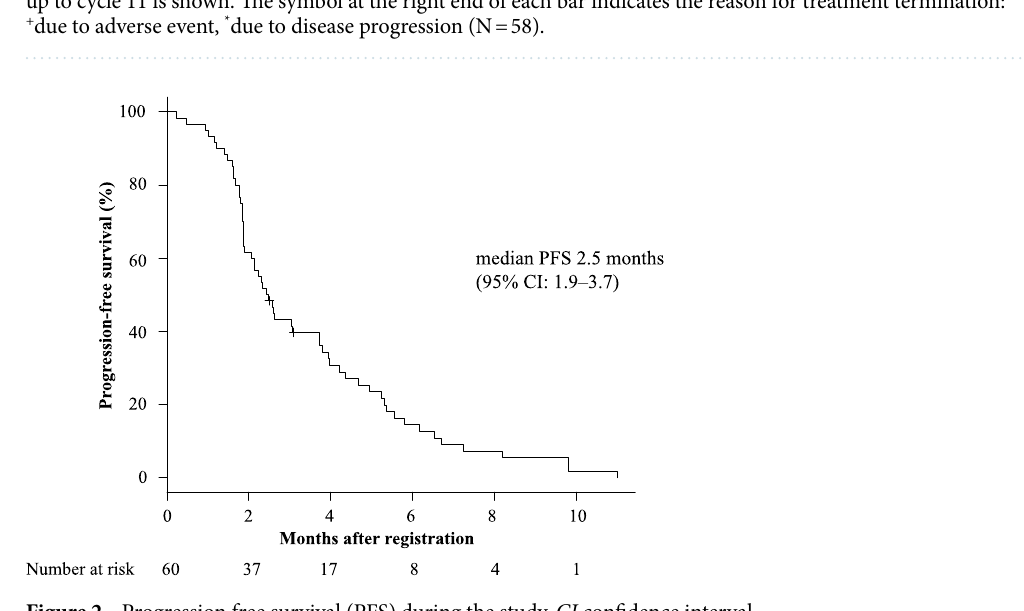
Figure 2. Progression free survival (PFS) during the study. CI confidence